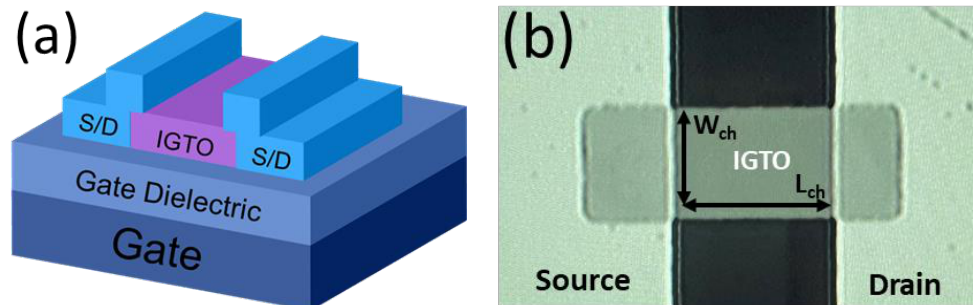
Figure 1. ( a ) Schematic view and ( b ) optical image of the fabricated IGTO TFTs prepared to examine the effects of varying oxygen content on the electrical characteristics of TFTs during channel layer deposition.